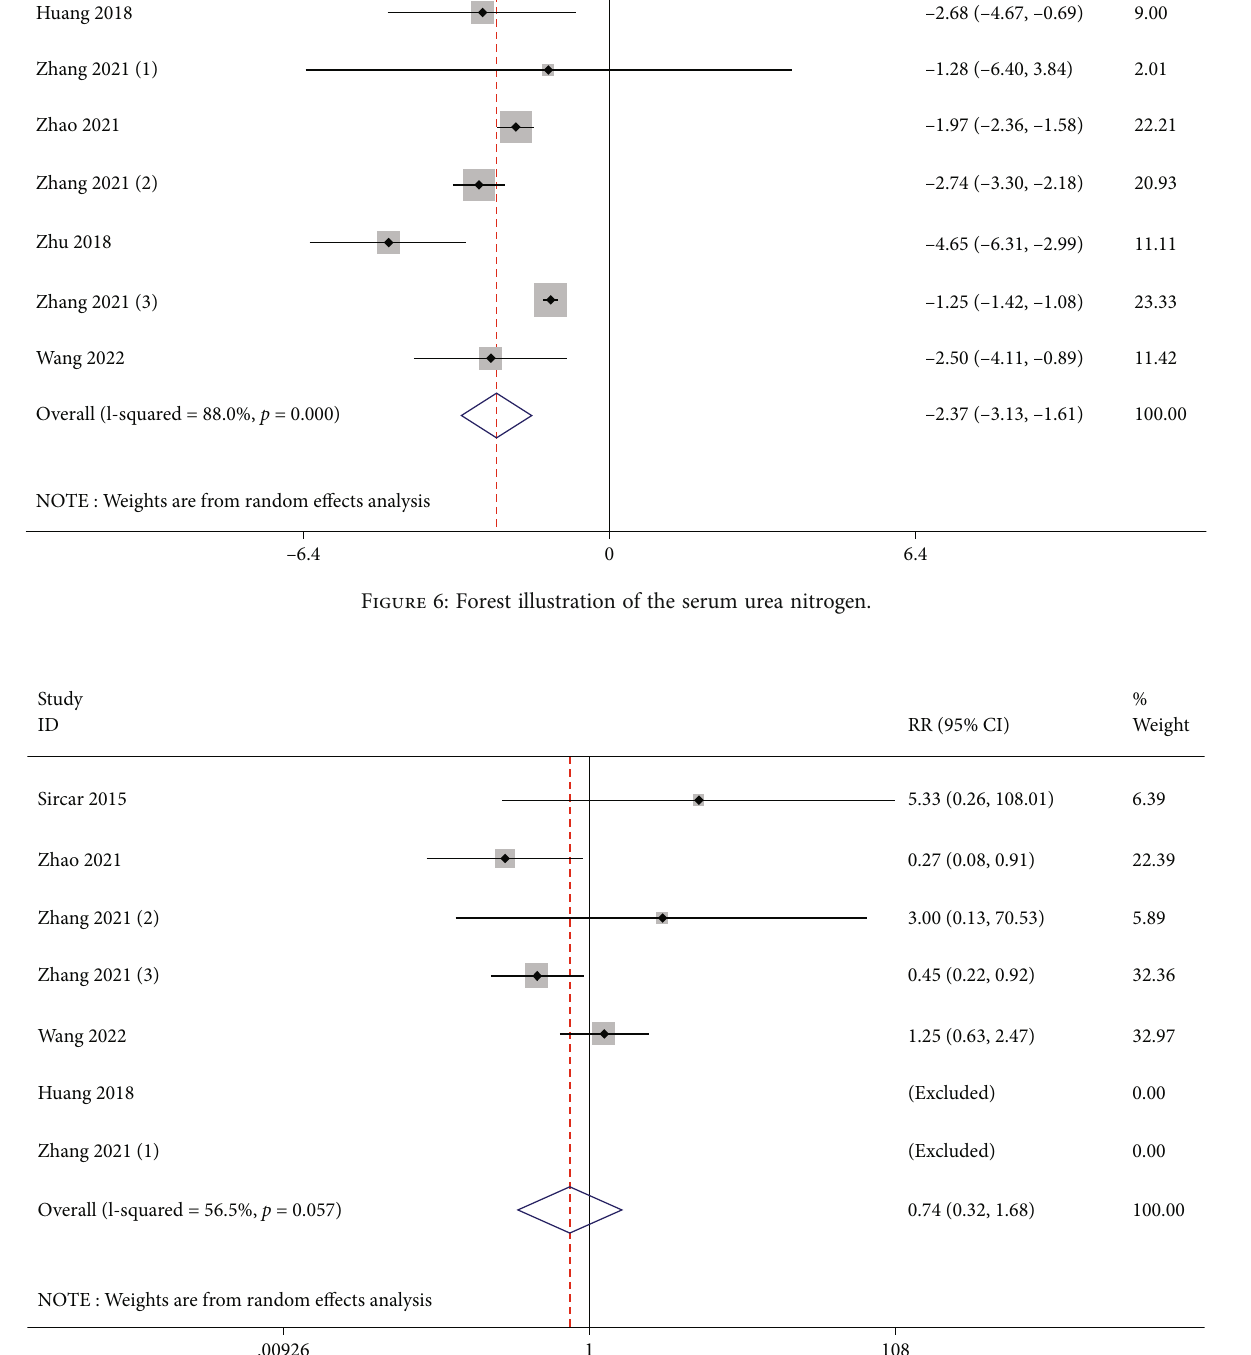
Figure 7: Forest illustration of the adverse